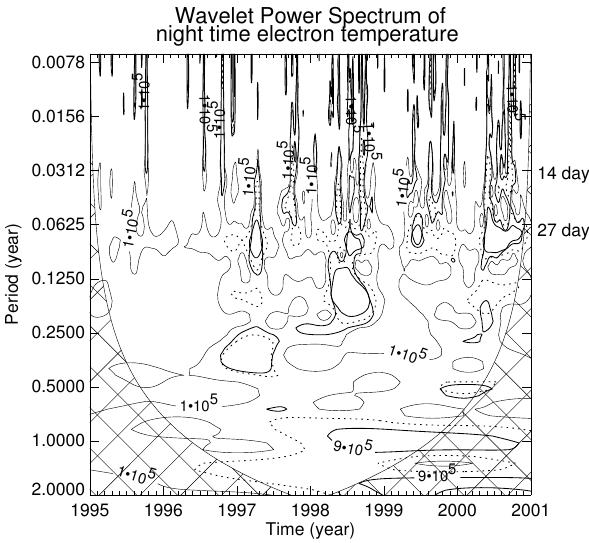
Fig. 8. Global wavelet spectra of average values of ion temperature during daytime and that of nighttime. Confidence levels same as described in Fig. 7.